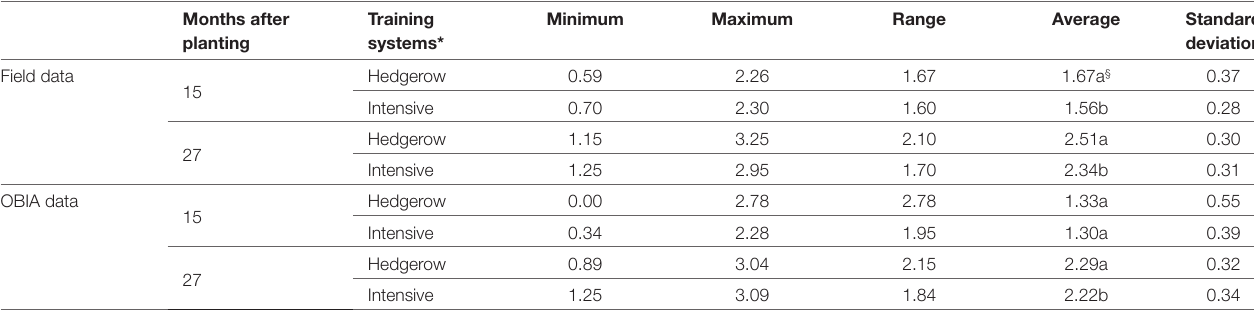
TABlE 3 | Summary of the field measured height and OBIA-estimated height for the matched trees at field scale. Months after